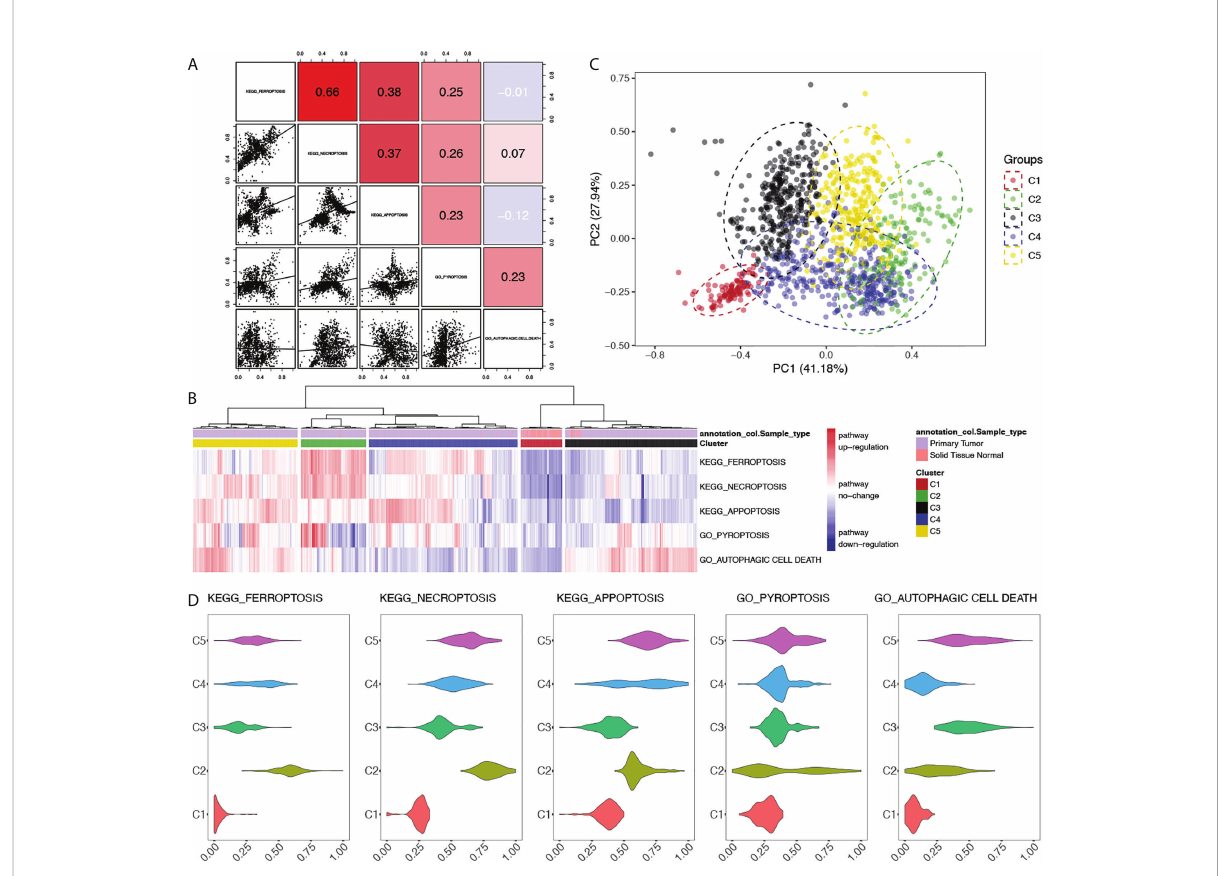
FIGURE 2 Clustering of breast cancer patients based on the alterations of programmed cell death pathways. (A) Correlations between PCD pathways in breast cancer. Correlational R-values between pathways were shown in the upper right with scatter plots in the bottom left. Color was illustrated according to the R-value. Red: R > 0, blue: R < 0. (B) Heatmap of clustering based on the PDS of PCD pathways of breast cancer patients with sample type annotation. (C) Principle components analysis (PCA) based on the PDS of PCD pathways with clusters of breast cancer patients illustrated with different colors. (D) Comparisons of PDS of each PCD pathways between clusters. P -value < 0.05 was considered signi fi